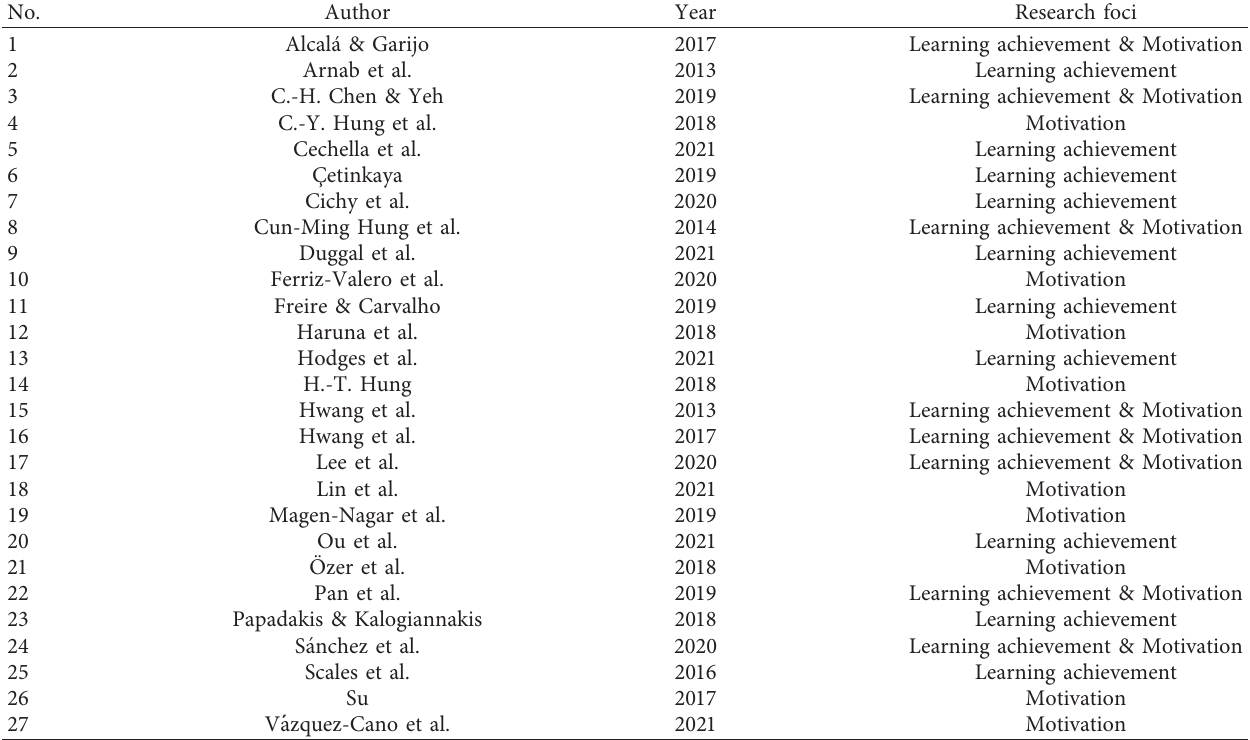
Table 2: The studies examining the effects of gamification platforms including Classcraft and extracted for the meta-analysis No.